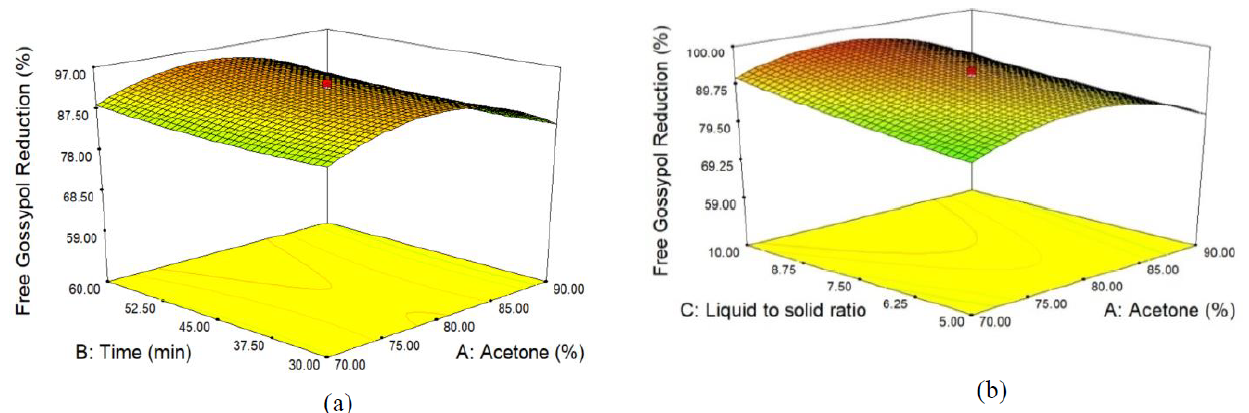
Figure 5. ( a ) 3D surface plot between time of extraction and acetone ( b ) 3D surface plot between LSR and acetone.